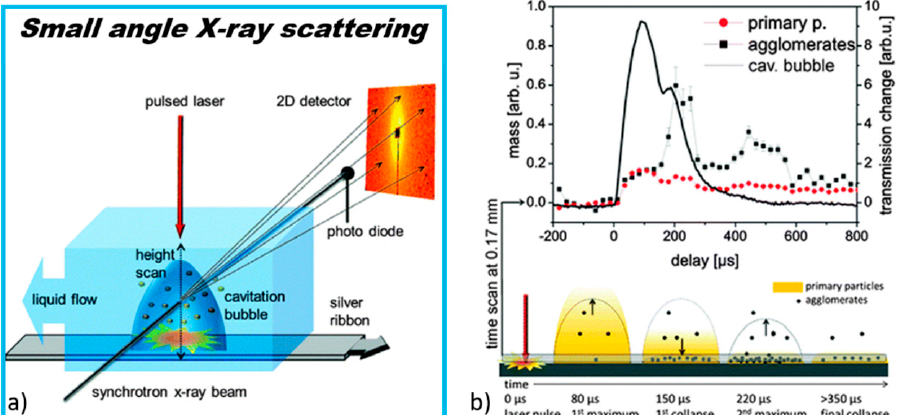
Figure 9. ( a ) Sketch of the experimental set-up for small-angle X-ray scattering technique. ( b ) Upper: distribution of the mass of the agglomerates and primary particles as a function of bubble lifetime (40 µ s gate). Lower: a sketch of the particle distribution inside the bubble volume for several characteristic delays. (Ag target, laser pulse width = 6 ns, laser energy = 10 mJ, laser wavelength = 1064 nm, laser frequency = 200 Hz) (Reproduced from Ref. [29] with permission from the PCCP Owner Societies).